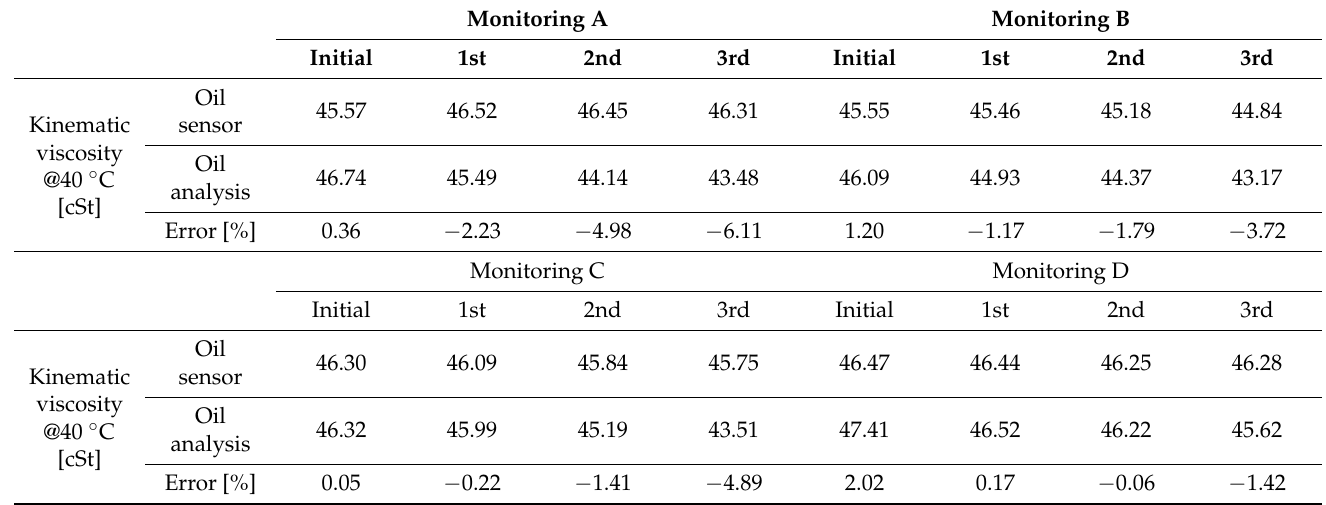
Table 8. Comparison of sensing and measured value of the kinematic viscosity for excavators.